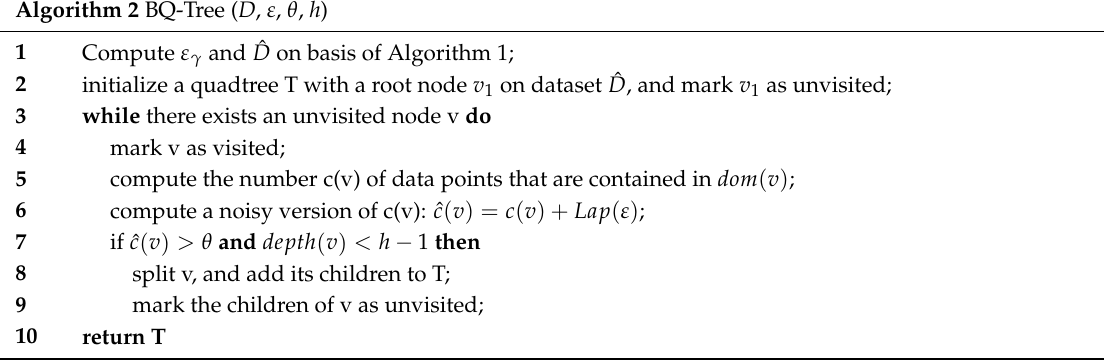
Algorithm 2 BQ-Tree ( D , ε , θ , h